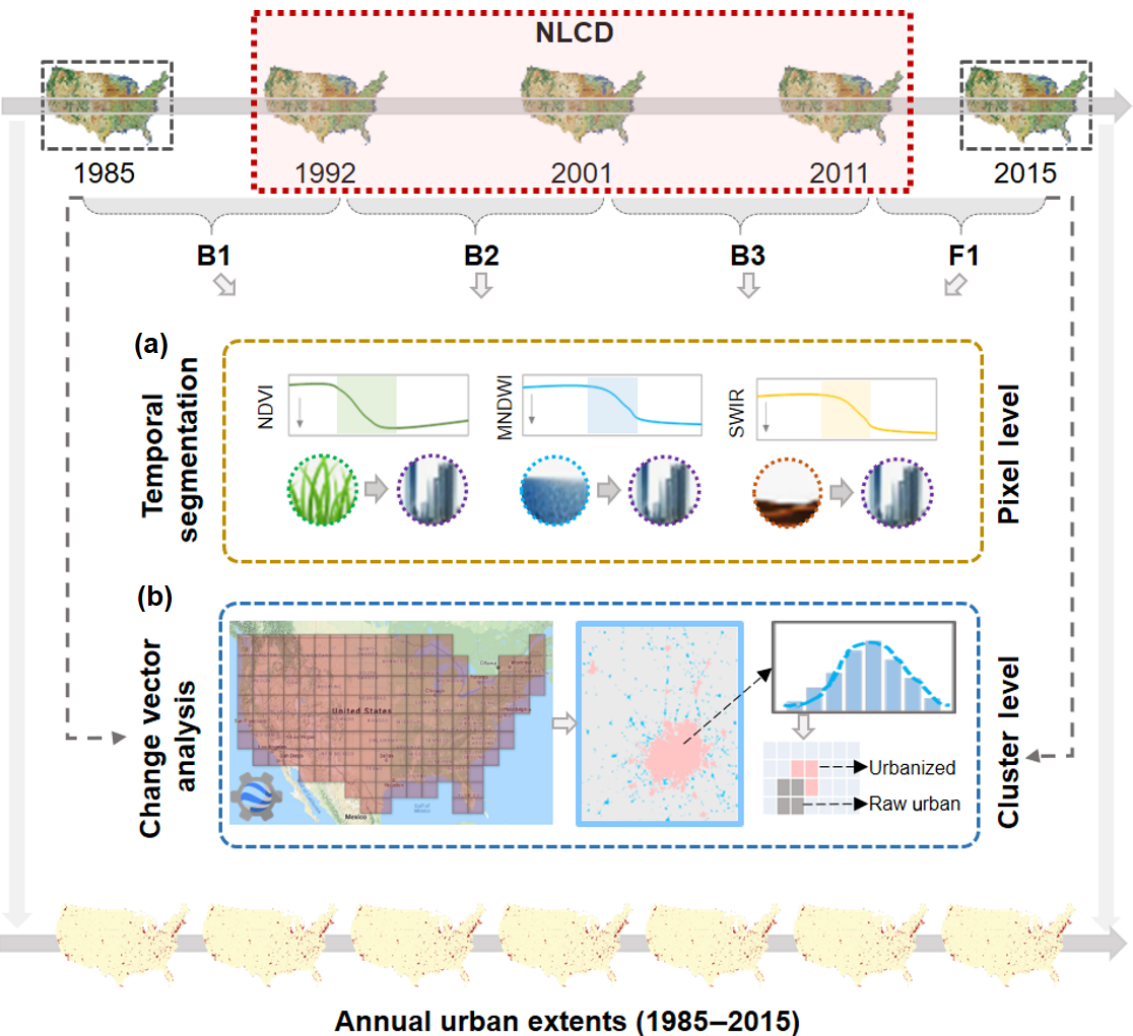
Figure 1. The proposed framework for mapping annual urban extent dynamics in the conterminous US through the detection of the urbanized year at the pixel level using the temporal segmentation approach (a) and classifying urbanized areas at the cluster level in periods B1 and F1 using the change vector analysis (b) (Basemap data© 2019